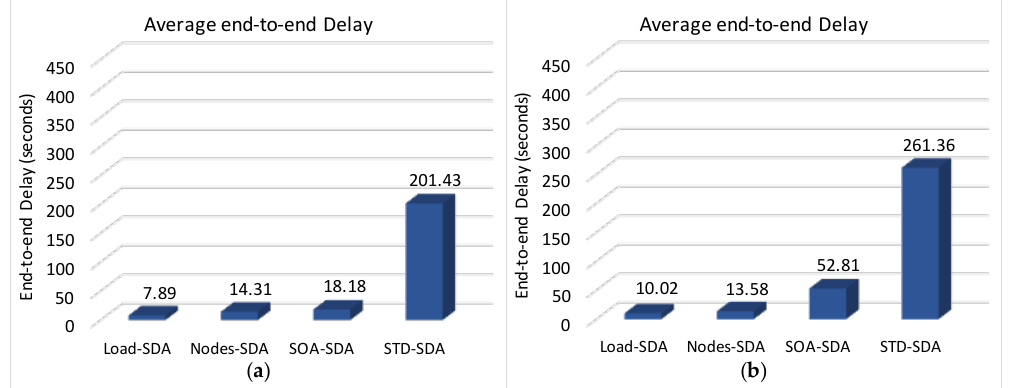
Figure 22. Average end-to-end delay for the monitoring traffic with a shorter beacon interval: ( a ) Unconditioned Scenario; ( b ) Conditioned Scenario.